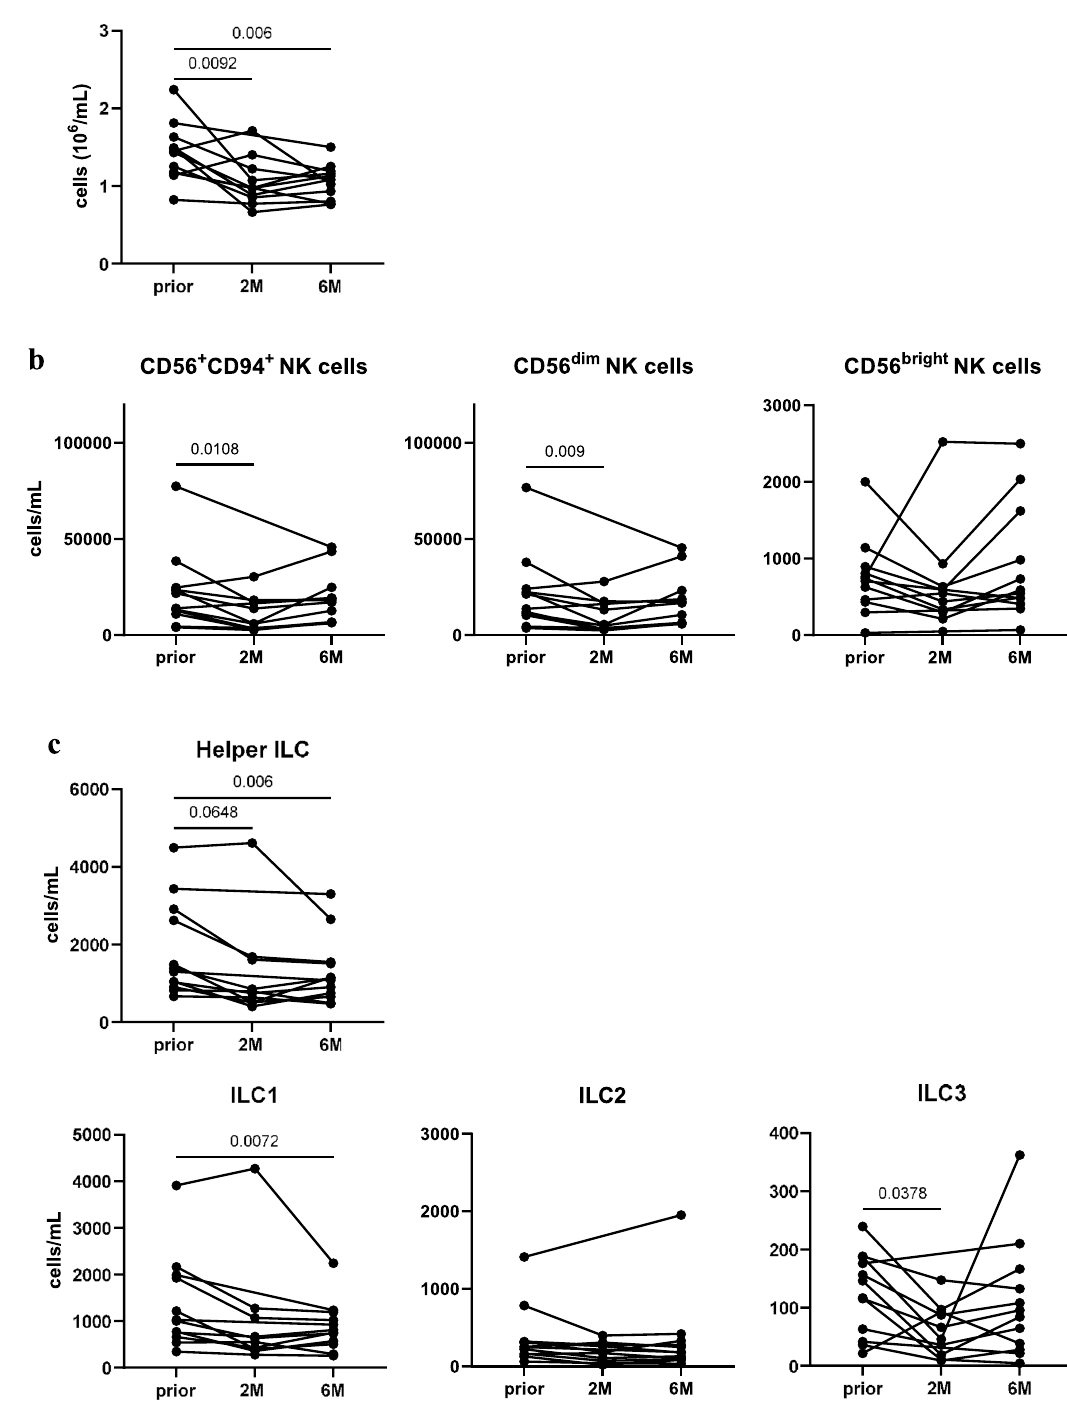
Figure 2. CladT reduce ILC but exempt CD56bright NK and ILC2 subsets. ( a ) Peripheral blood mononuclear cell (PBMC) count (10 6 /mL) across patients at baseline ( prior , n = 12), and 2 ( 2M , n = 10) and 6 months ( 6M , n = 12) following the first administration of CladT. ( b ) Cell counts (cells/mL) of CD56+CD94+, CD56dim and CD56bright NK cells at prior, 2M and 6M . NK cells were defined as live CD45+Lin−(CD3−CD19− CD14−CD11c−CD123−CD34−FcεRIa−TCRab−) CD56+CD94+, and further subdivided into CD56dim and CD56bright subpopulations. ( c ) Cell counts (cells/mL) of helper ILC (defined as live CD45+Lin−(CD3−CD19− CD14−CD11c−CD123−CD34−FcεRIa−TCRab−) CD56−CD94−CD127+helper ILC), and ILC1 (CD294− CD117−), ILC2 (CD294+CD117+/−) and ILC3 (CD294−CD117+) subsets at prior (n = 12), 2M (n = 10) and 6M (n = 12). A linear mixed-effects model was calculated to compare between MS patients before and after treatment. 4999 permutations were then run to calculate p-values. Holm’s corrections were used for multiple comparisons which were performed to compare the different timepoints ( prior , 2M & 6M ). p-values of p < 0.1 are indicated on the